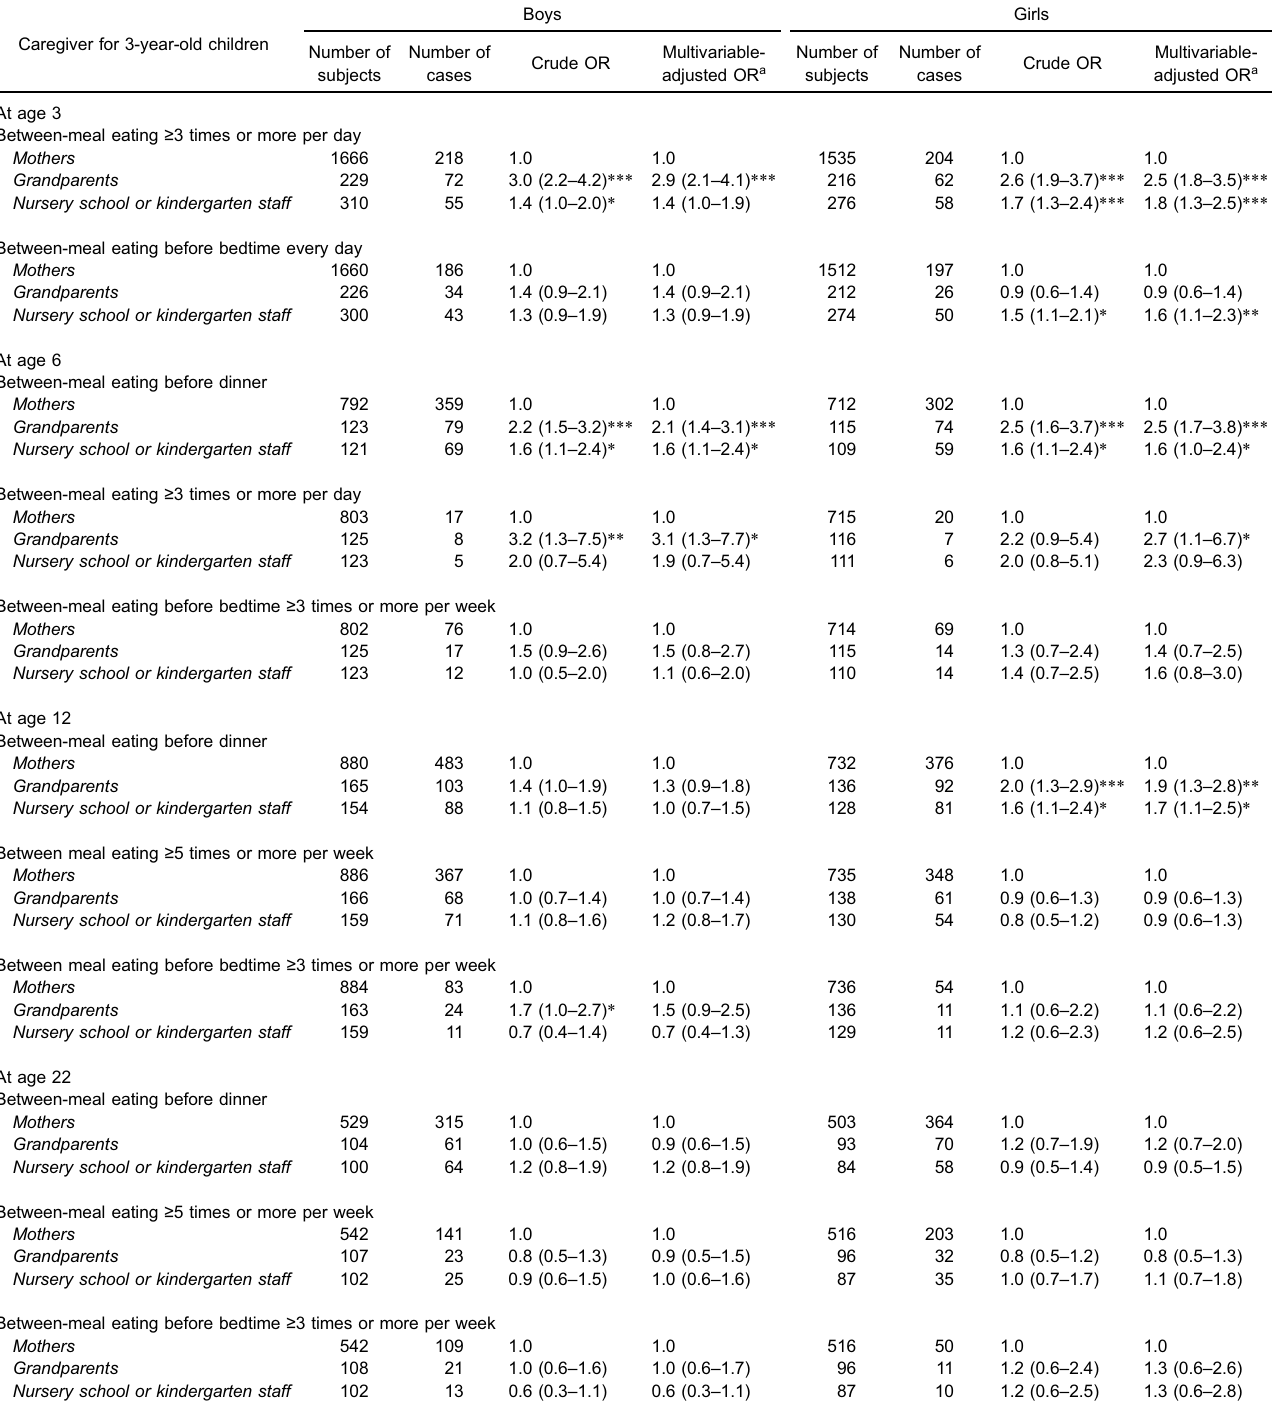
Table 2. Sex-speci fi c and multivariable-adjusted odds ratios of eating habits according to caregivers Caregiver for 3-year-old children